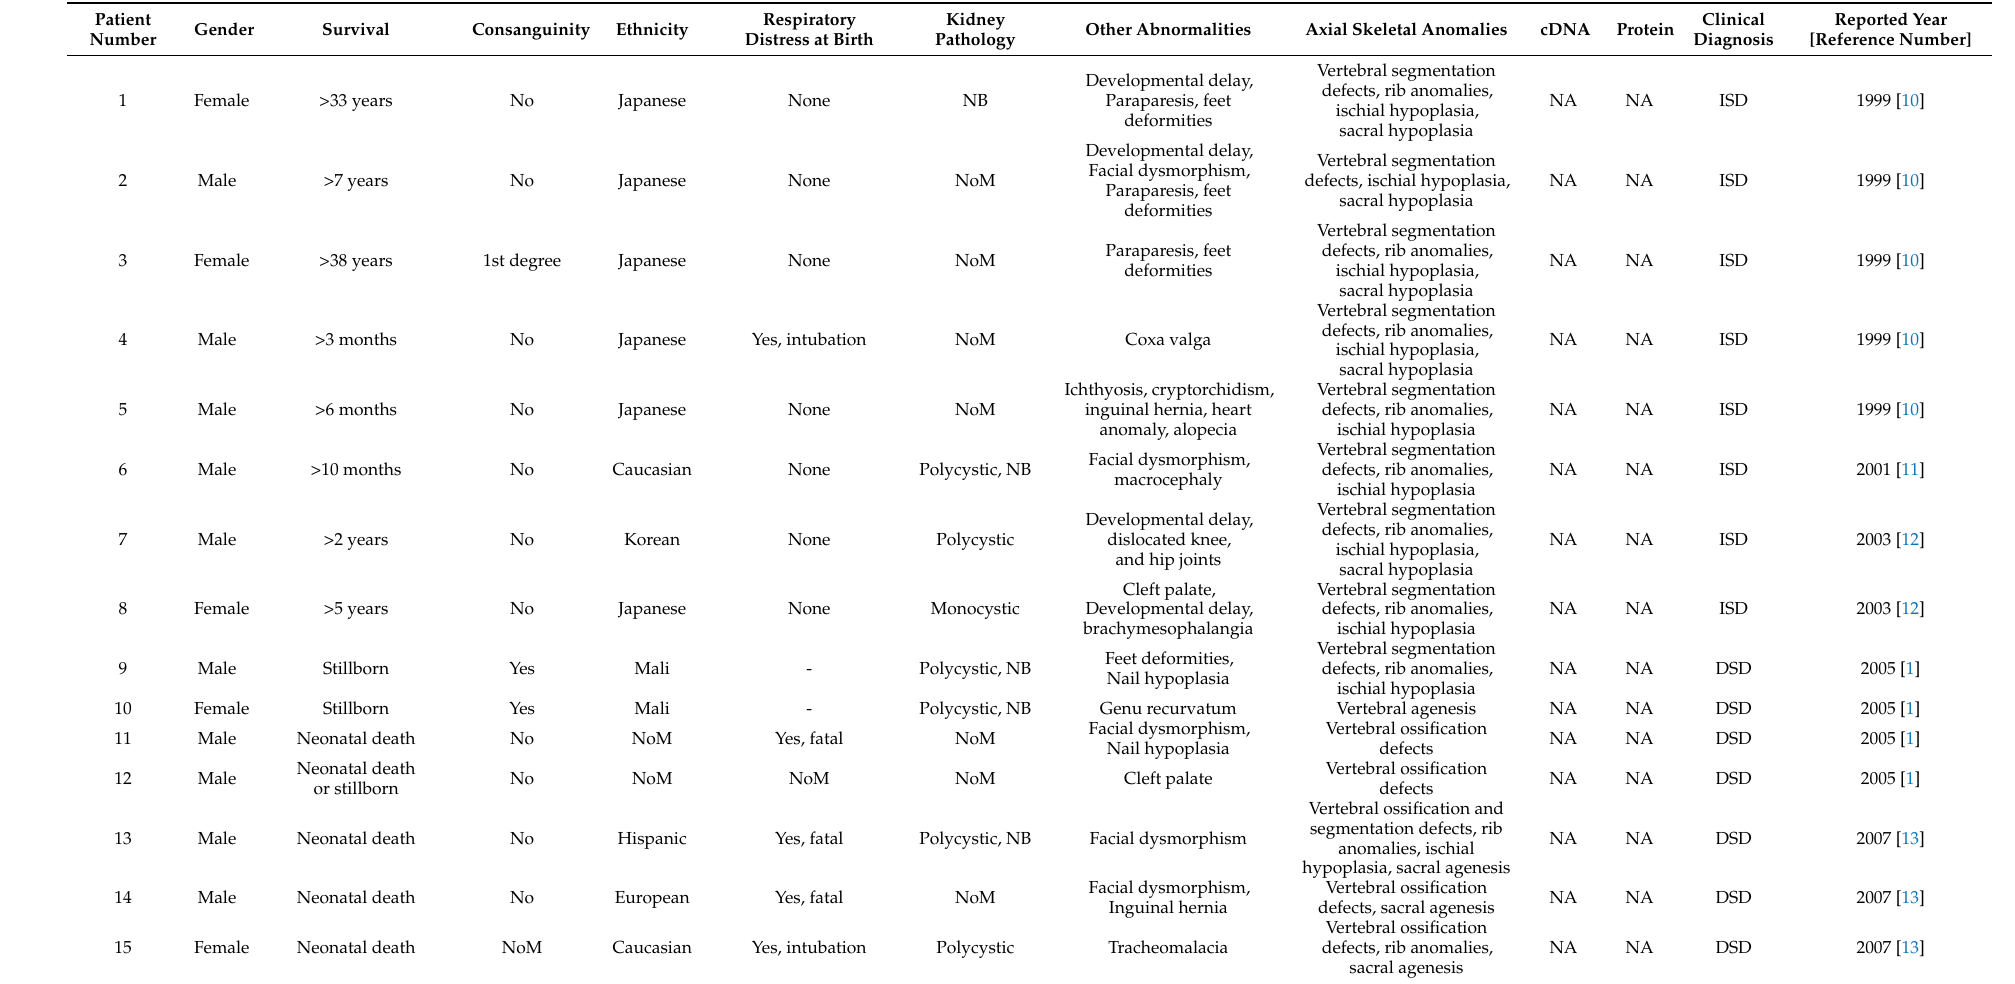
Table 2. Summary of clinical manifestations and genetic mutations of previously reported patients with ISD and DSD and the patient in the current